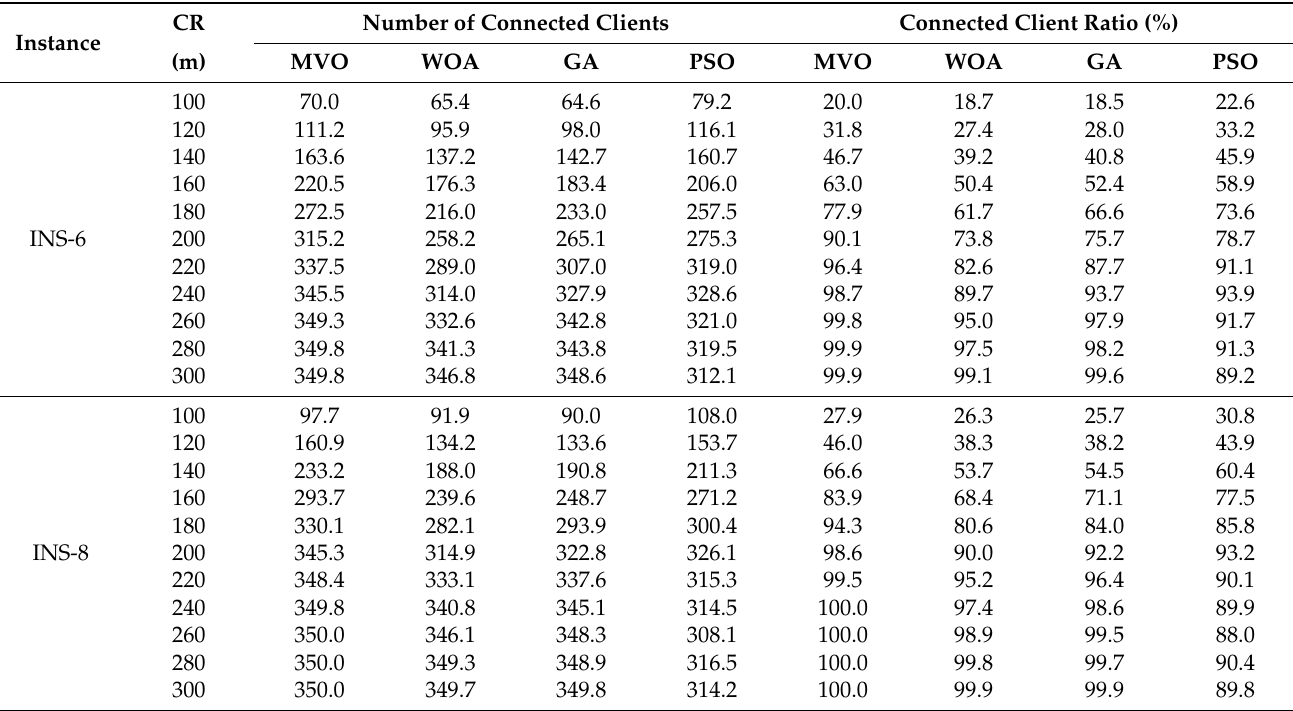
Table 8. Performance comparison of the number of connected clients and CCR when executing INS-6 and INS-8.